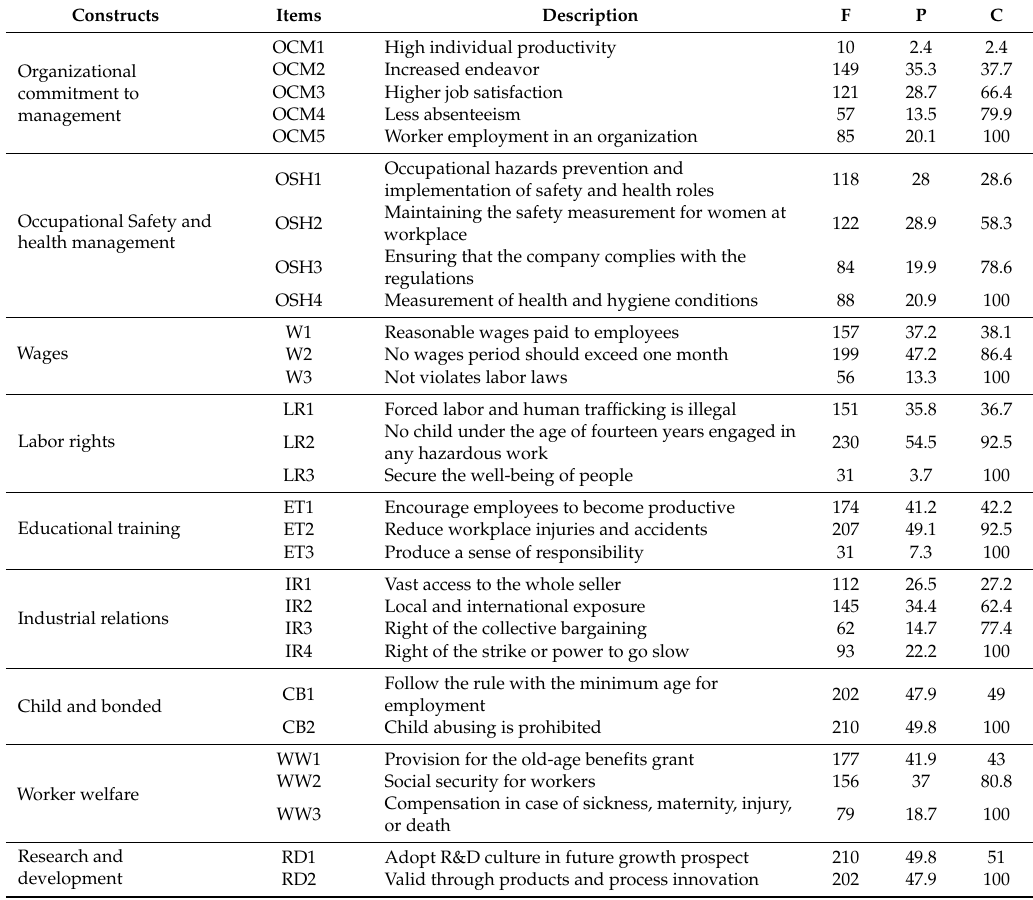
Table 3. Supplier social sustainable supply chain management